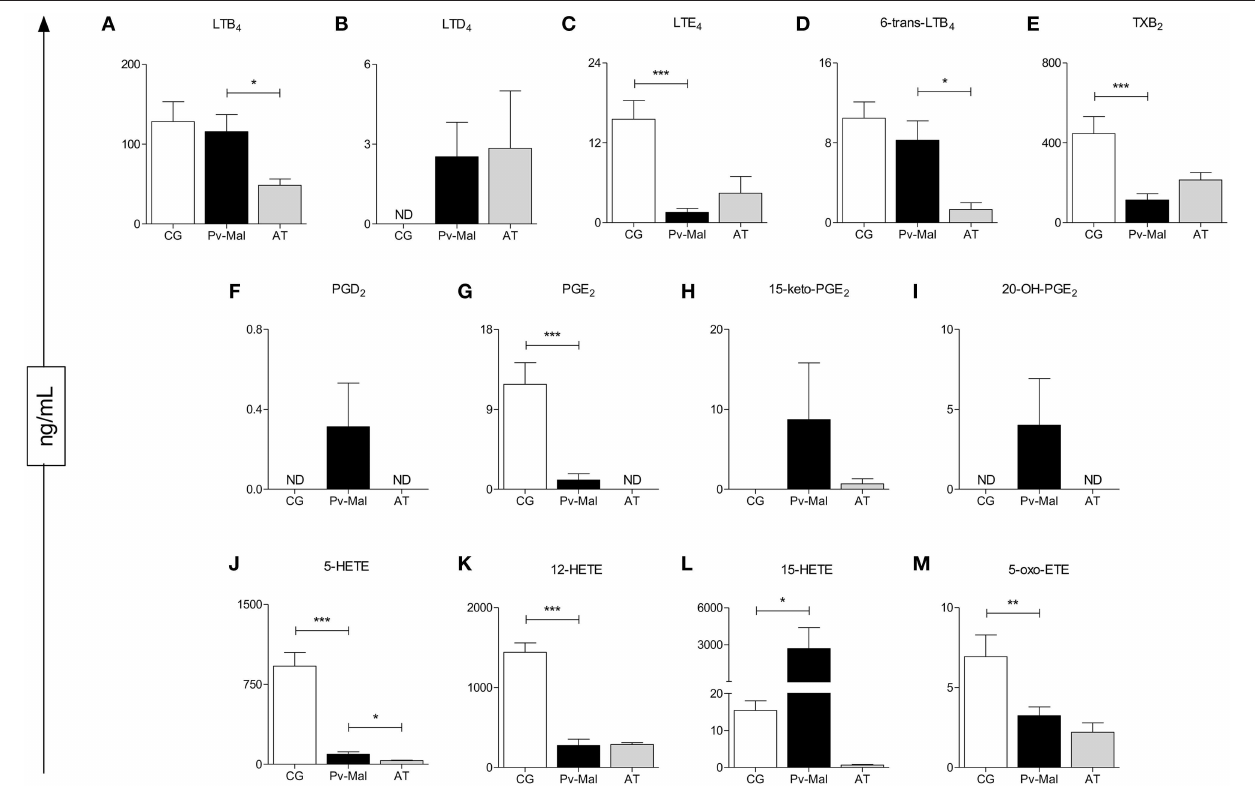
FIGURE 1 | Identification and quantification of eicosanoids after stimulation with Thapsigargine, from control group (white bar), Pv -malaria patients (black bar) and patients who returned 28 days after treatment, understood as the period of convalescence (gray bar). * p < 0.05, ** p < 0.01, *** p < 0.0001 between groups studied. ND = Concentration not detected. The quantifications of these lipid mediators were measured using high performance liquid chromatography-mass spectrometry (HPLC-MS).